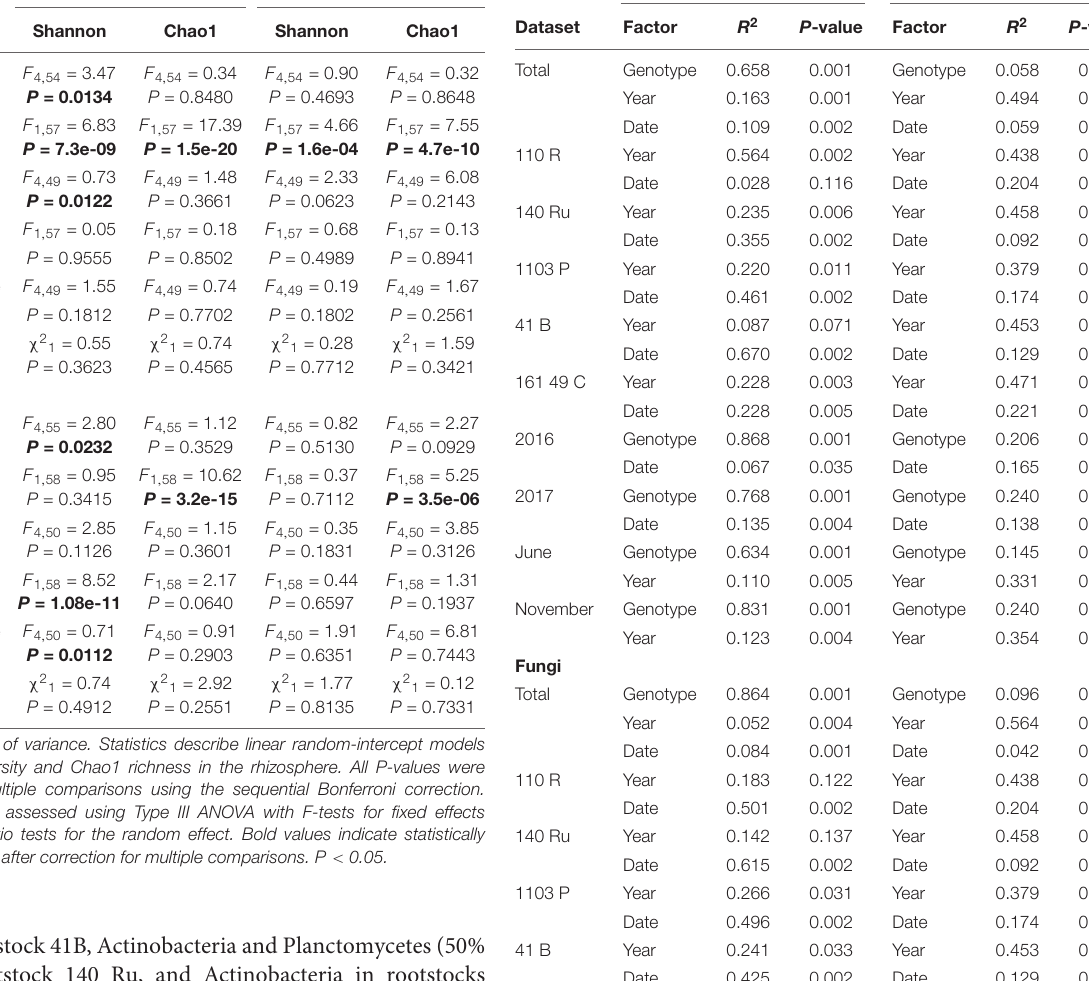
TABLE 1 | Experimental factors predicting α -diversity of rhizosphere associated fungal and bacterial communities in Aldea and Olite vineyards. Bacteria Aldea Olite Shannon Chao1 Shannon Chao1